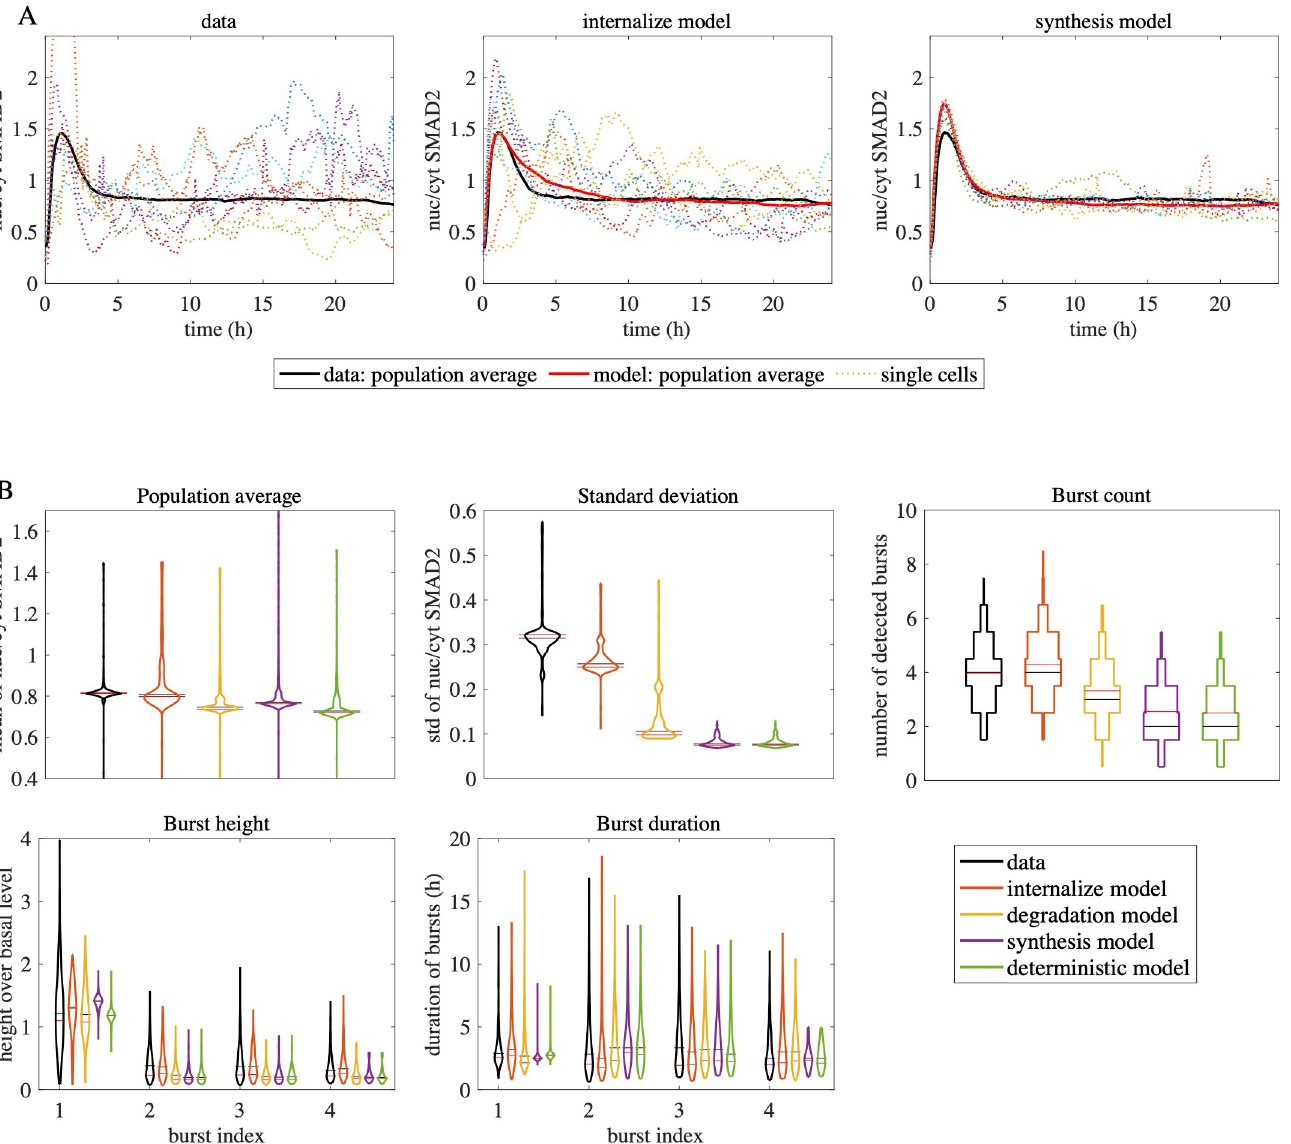
Fig 5. Stochastic internalization model achieves the best fit to the data. A: Nuc/cyt SMAD2 ratio trajectories of data and stochastic models. Experimental data (left), the best-fit internalization model (center) and the best-fit synthesis model (right) are compared for stimulation with 100 pM TGF- β . Examples of single cell trajectories of the nuc/cyt SMAD2 ratio (dashed lines) are shown in addition to the population average over all cells (thick black line). For comparison, the population average of the experimental data (thick red line) is shown alongside with the simulations. B: Population summary and burst feature statistics in the data and stochastic models. Population summary and single cell burst statistics are compared in terms of violin plots for experimental data and the stochastic models in case of stimulation with 100 pM TGF- β . The ‘deterministic’ model which introduces noise only through experimental control data (0 pM TGF- β , see Methods) is additionally considered. The mean and the median are indicated by black and red horizontal lines. Distributions of burst height and duration are compared for the first four detected bursts (burst index). The shown model distributions are based on 5000 simulated cells using the best fit noise parameters. In summary, the internalization model achieved the best fit to the data. For a comparison with other stochastic methods see S5 Fig and S7